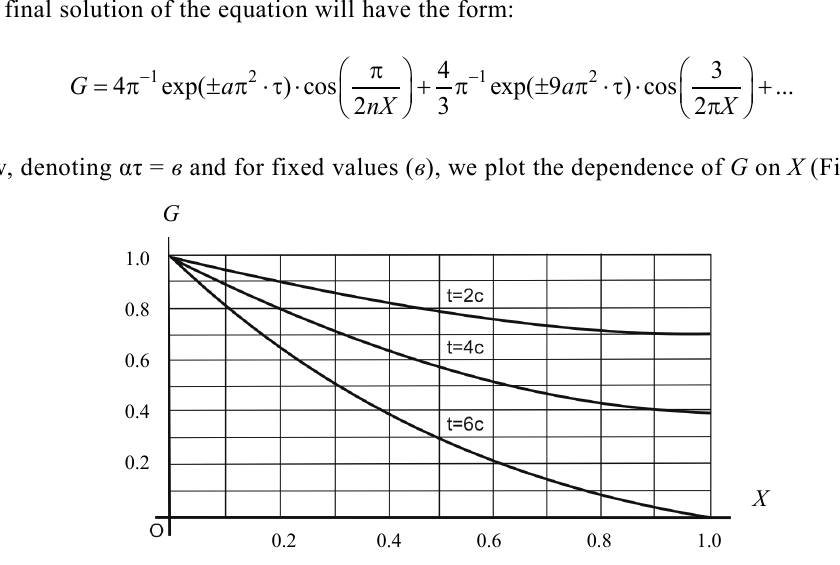
Fig. 2. Approximate distribution of the concentration of trash impurities and dust in the